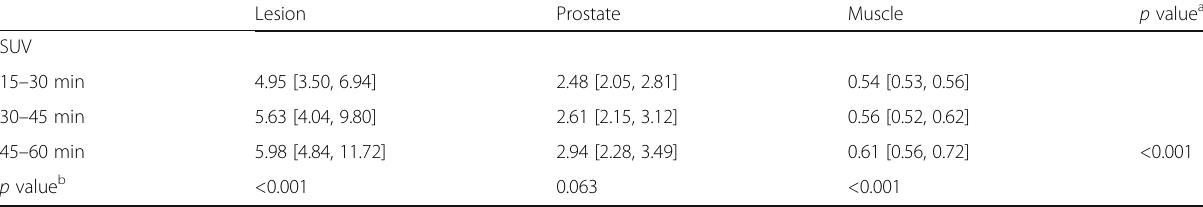
Table 2 68 Ga-PSMA-11 SUV compared between regions and time-windows of the PET scan Lesion Prostate Muscle p value a